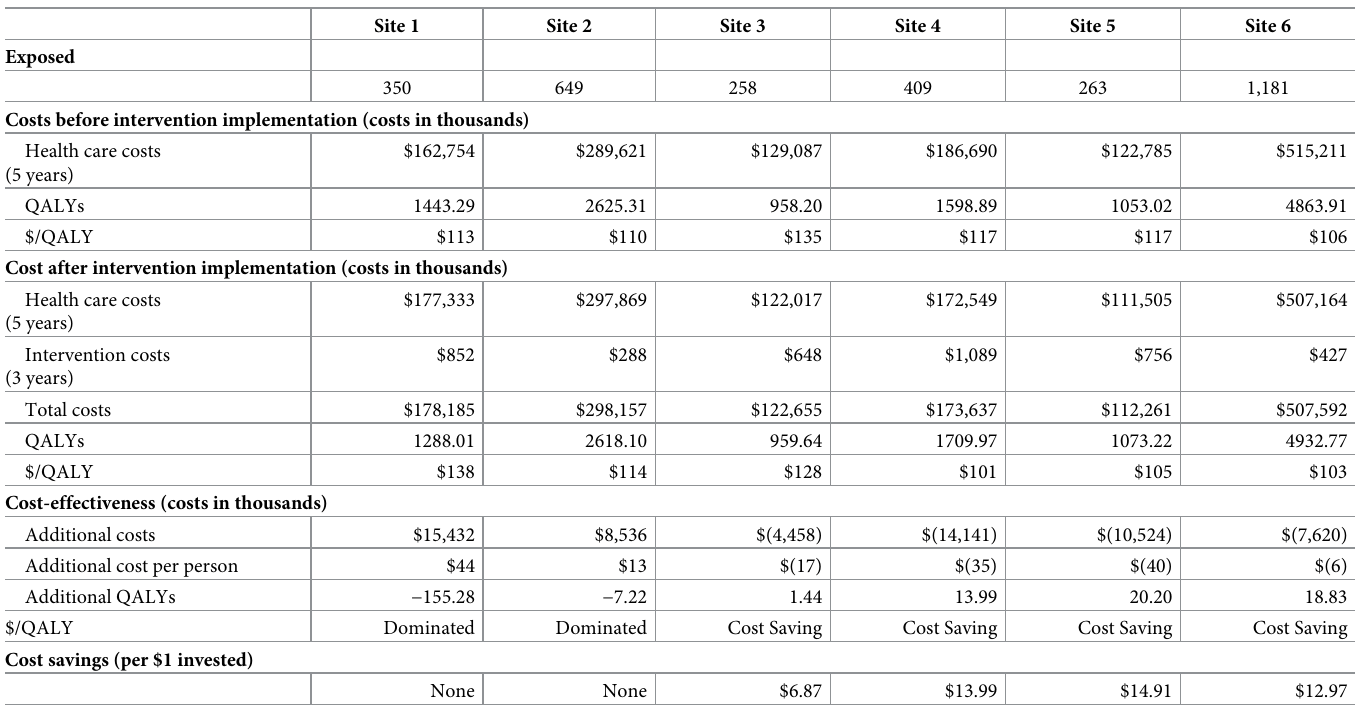
Table 4. Cost-effectiveness and return on investment for HIT